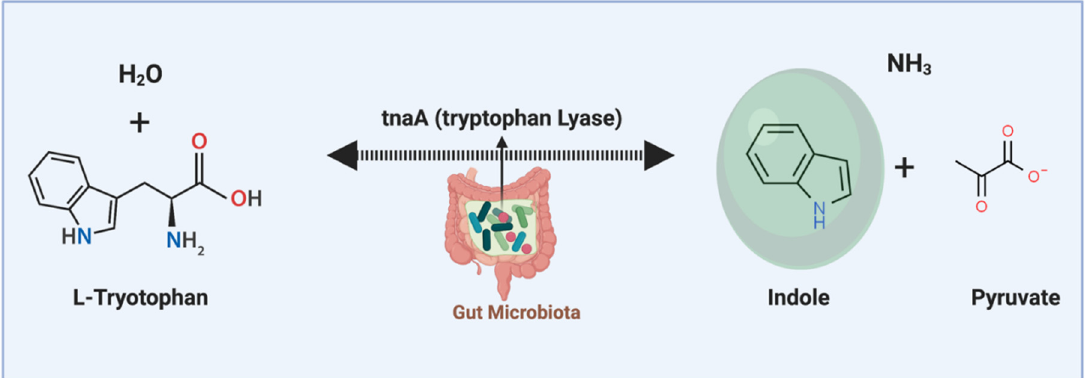
Figure 4. Indole is a gut microbiota-derived metabolite. Indole is produced from tryptophan amino acid through the action of the tryptophan lyase enzyme. Indole is an aromatic heterocyclic organic molecule and has a bicyclic structure. Indole has anti-inflammatory regulatory effects on intestinal epithelial cells and immune cells in the gut and distal organs (through circulation) in the